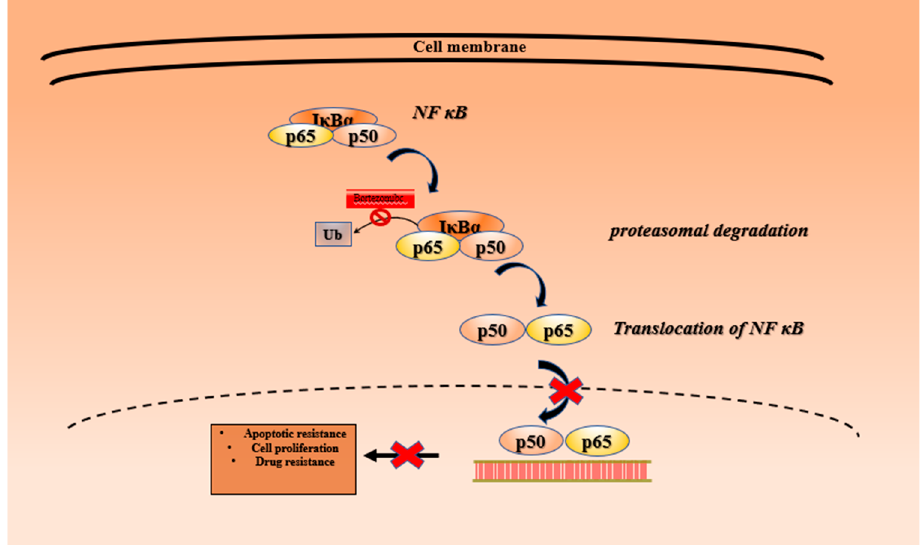
Figure 13. Mechanism of action of bortezomib. X : Inhibition.